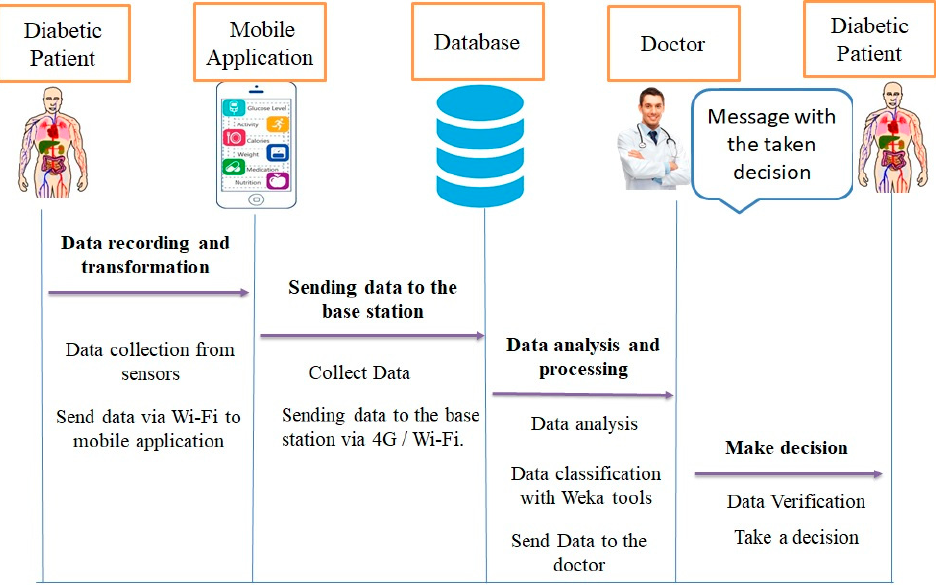
Figure 6. Structure of information transmission.